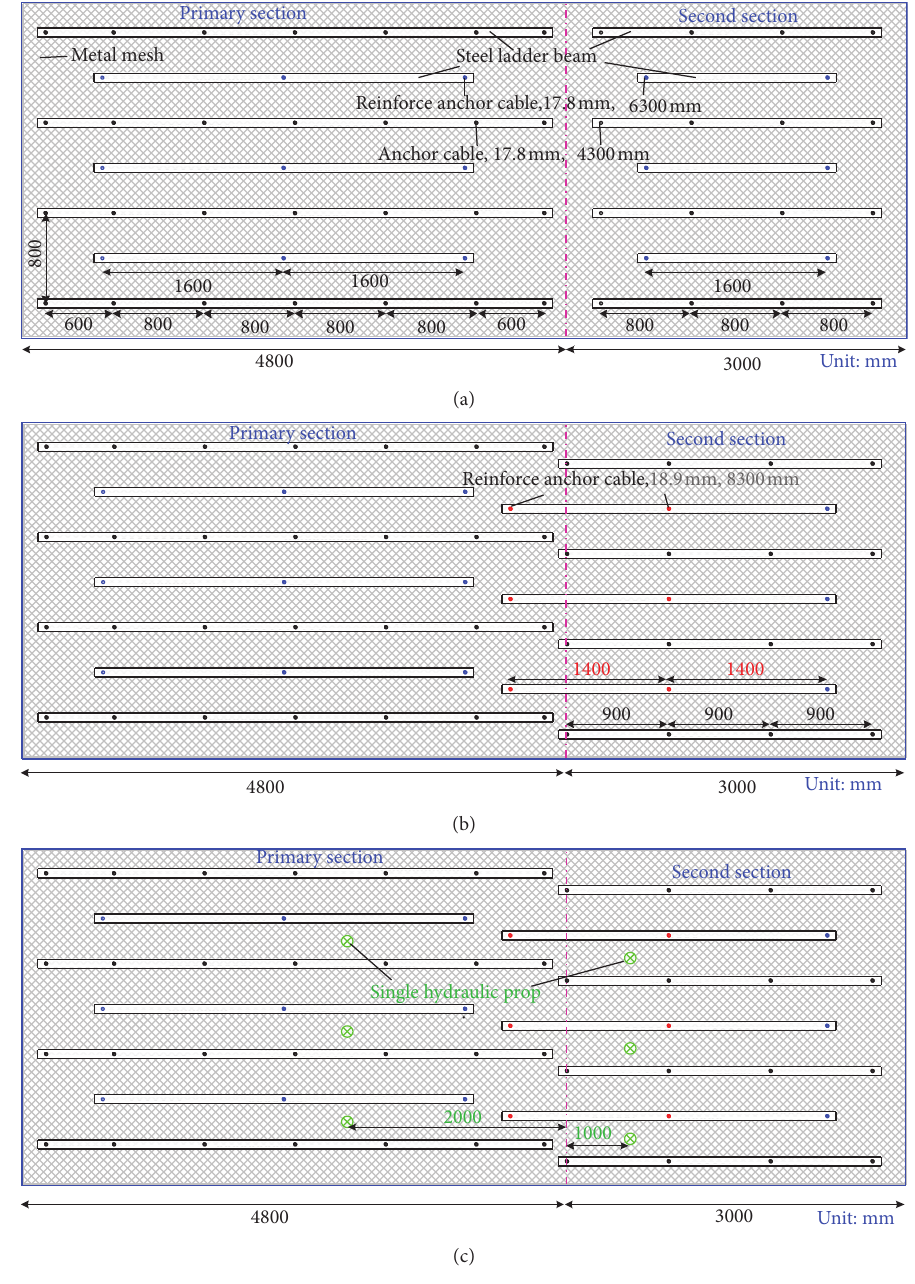
Figure 11: Plan view of three roof support schemes, (a) Scheme 1; (b) Scheme 2; (c) Scheme